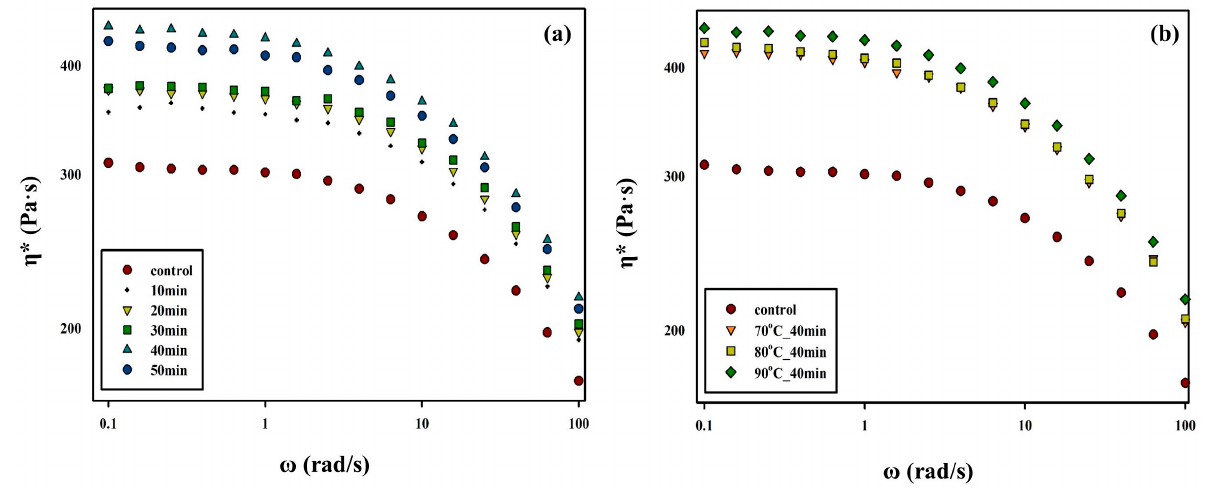
Figure 5. Complex viscosity ( η *) of PBSeT at T = 120 ◦ C: ( a ) complex viscosity of the PBSeT sample Figure 5. Rheological behavior of PBSeT at T = 120 °C: ( a ) complex viscosity of the PBSeT sample that underwent SSP at 90 °C for different lengths of time, ( b ) PBSeT sample that underwent SSP at that underwent SSP at 90 ◦ C for different lengths of time, ( b ) PBSeT sample that underwent SSP at different temperatures for 40 min. different temperatures for 40 min.